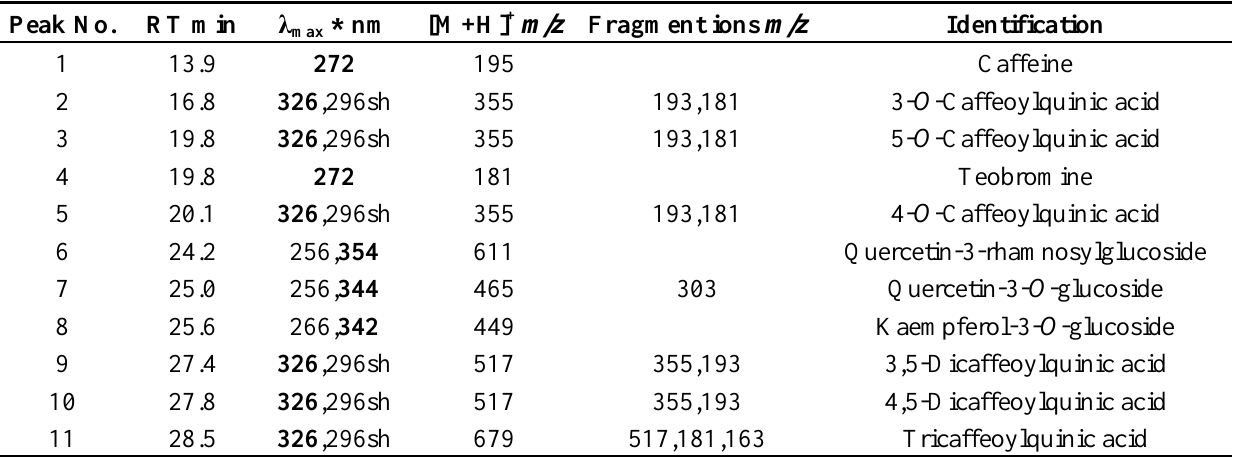
Table 1. Identifying characteristics of the phenolic compounds and purine alkaloids of beverages from Ilex paraguariensis